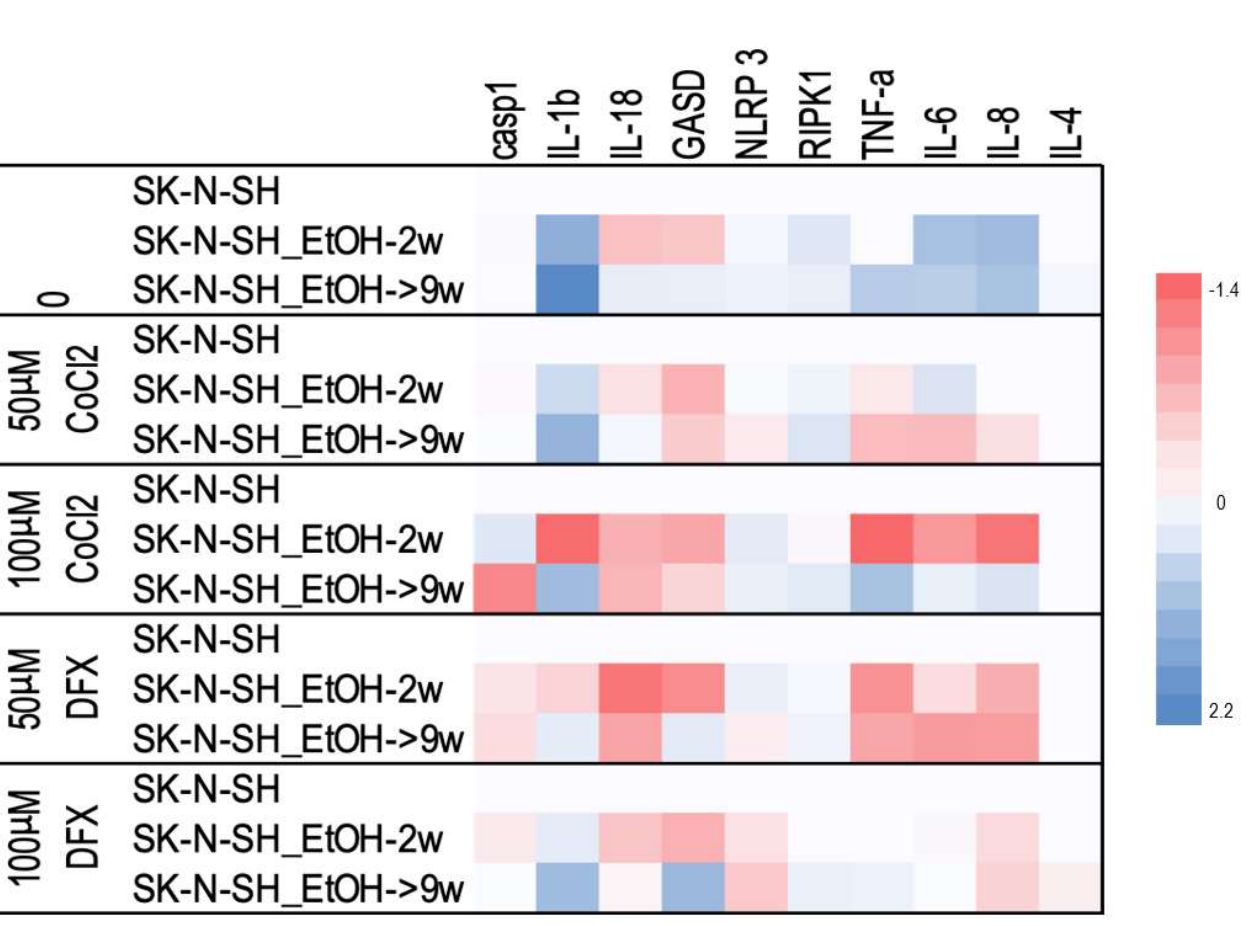
Figure 9. The effects of ethanol and hypoxic treatment on the gene expressions involved in pyroptosis and inflammation. Each numerical data was graphically represented using warm colors representing low-value data points and cool colours representing high-value data points.